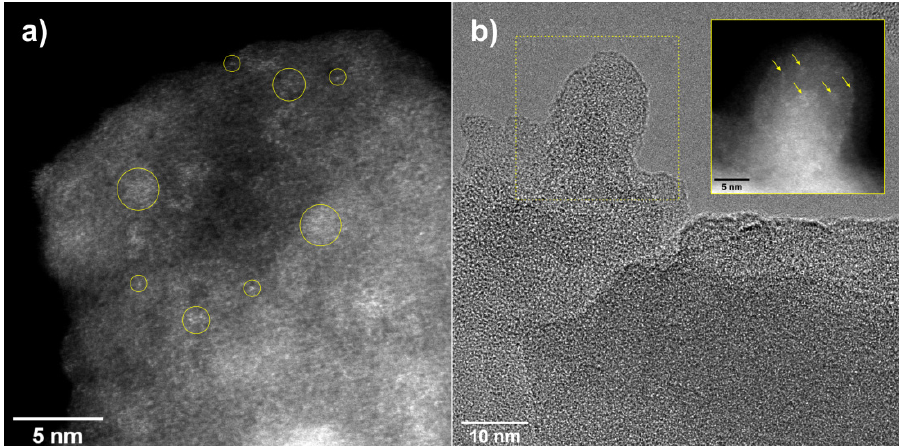
Figure 6. ( a ) HAADF-STEM image of sample A ; ( b ) HRTEM image of sample D and HAADF-STEM image of the marked region shown in inset. The marks on HAADF-STEM images indicate the location of highly dispersed Zr-species.